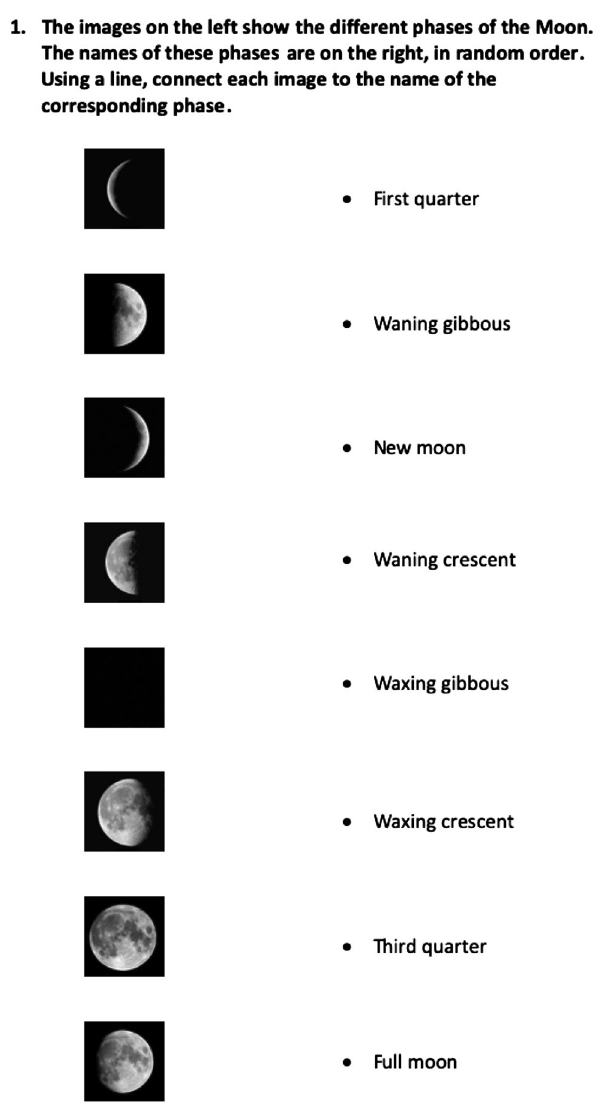
FIG. 1. Item 1 of the MPCI-MS: Association game between photos of lunar phases and their